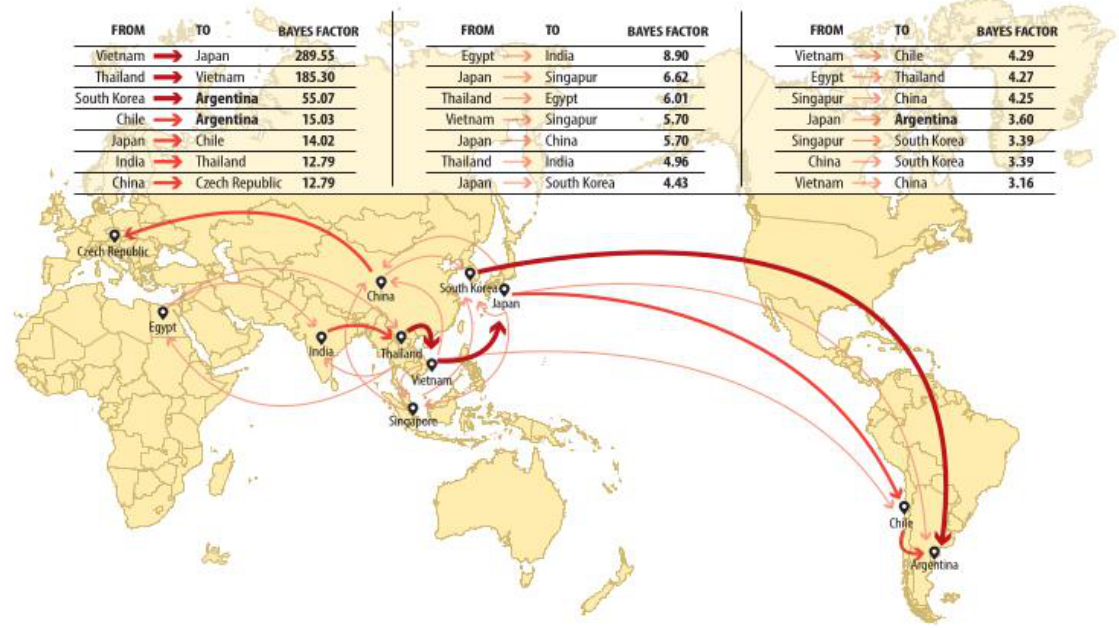
Figure 2. Global migration pattern of G8-lineage IV strains. Linkage points between countries are indicated from/to their center, and the width of the connection is proportional to the Bayes factor estimation according to the reference scale (only BF > 3.0 are displayed).